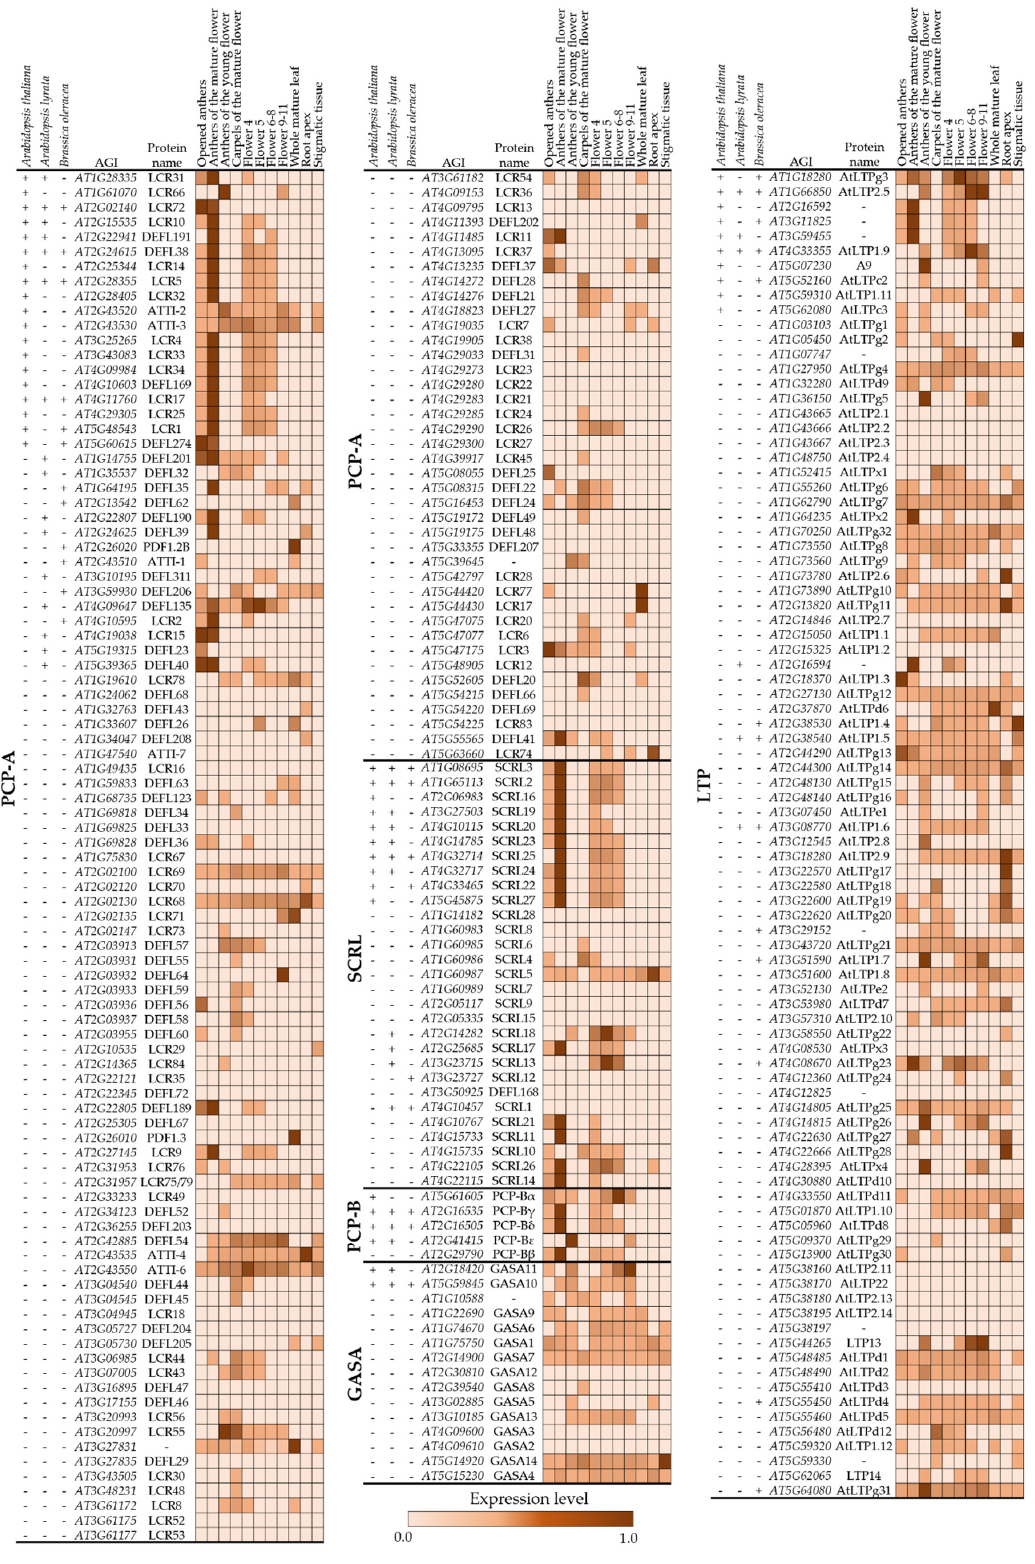
Figure 3. RNA-seq analyses from A. thaliana of the genes encoding five cysteine-rich protein (CRP) families identified from pollen coat proteomes. The ‘+’ and ‘-’ beside the Arabidopsis gene initiative (AGI) locus code indicate whether the protein was identified in the pollen coat proteomes in this